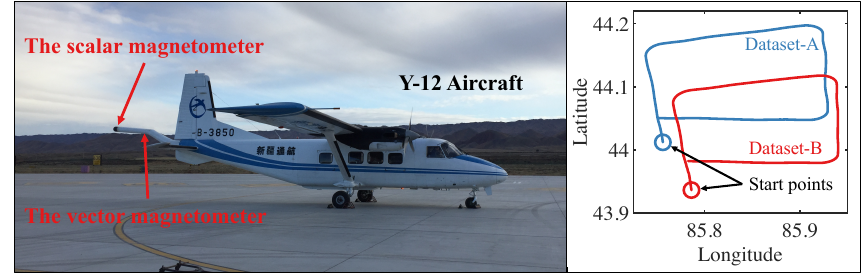
Figure 3. The aircraft used in the experiment.